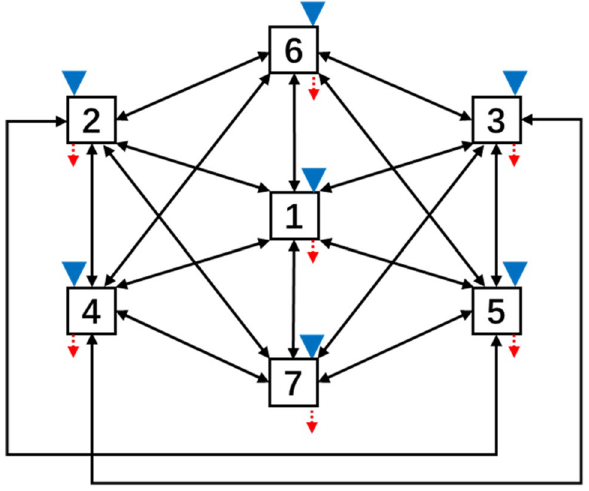
Fig. 2 The SEA model of the system shown in Fig. 1 (The blue arrows represent power inputs, the black arrows represent power flows between different subsystems through couplings, and the red arrows represent the powers dissipated due to internal damp- ing)